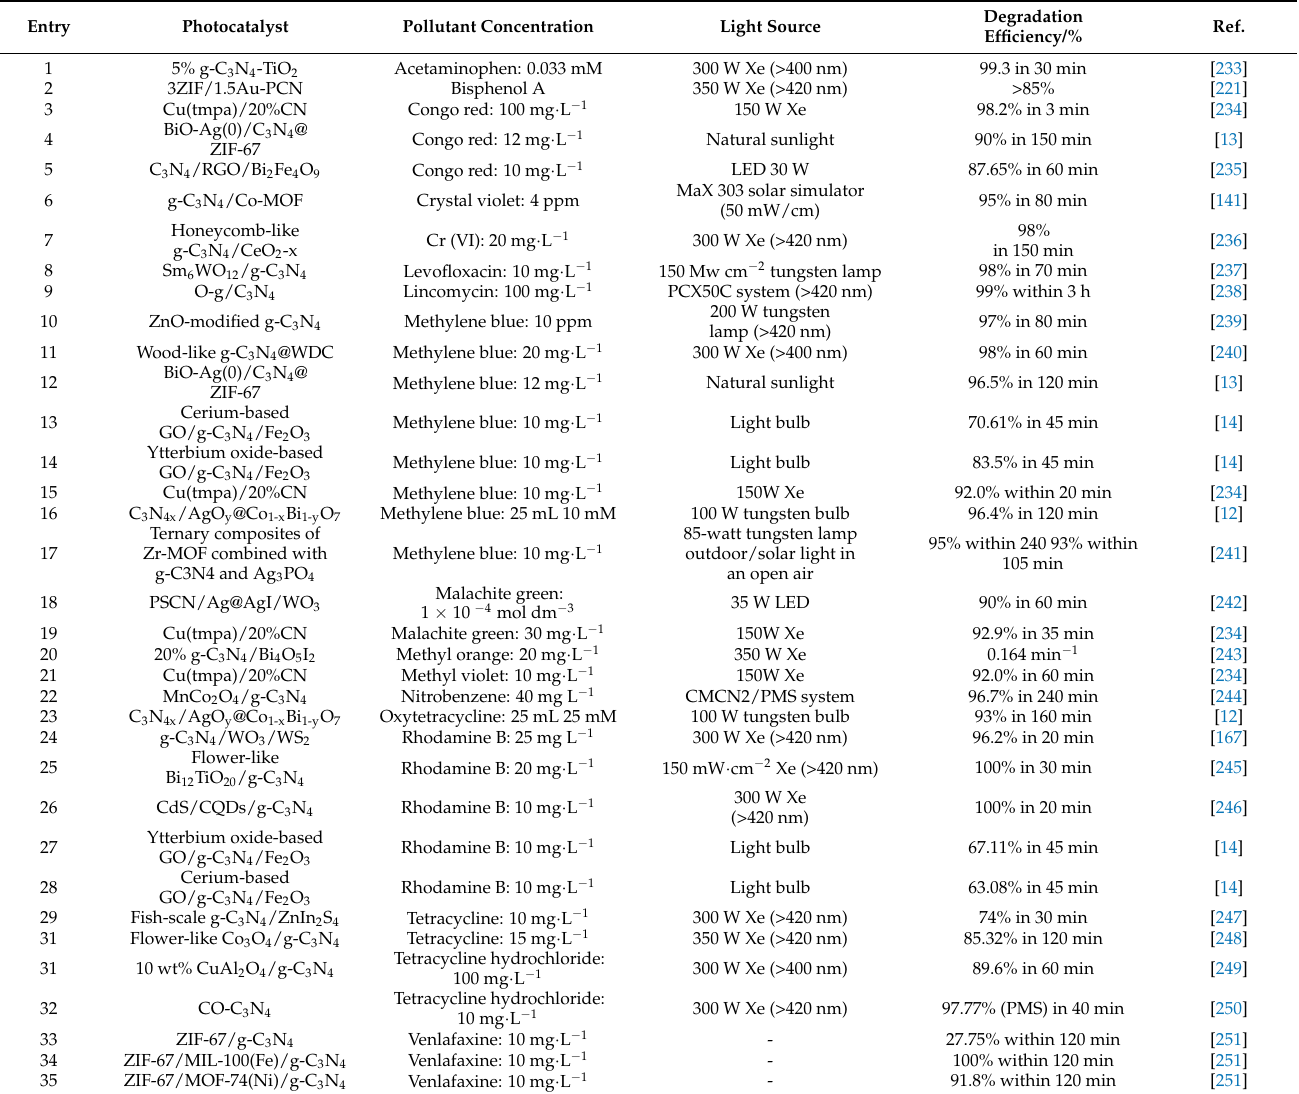
Table 3. Photocatalytic degradation of pollutants over g-C 3 N 4 -based materials reported within the last three